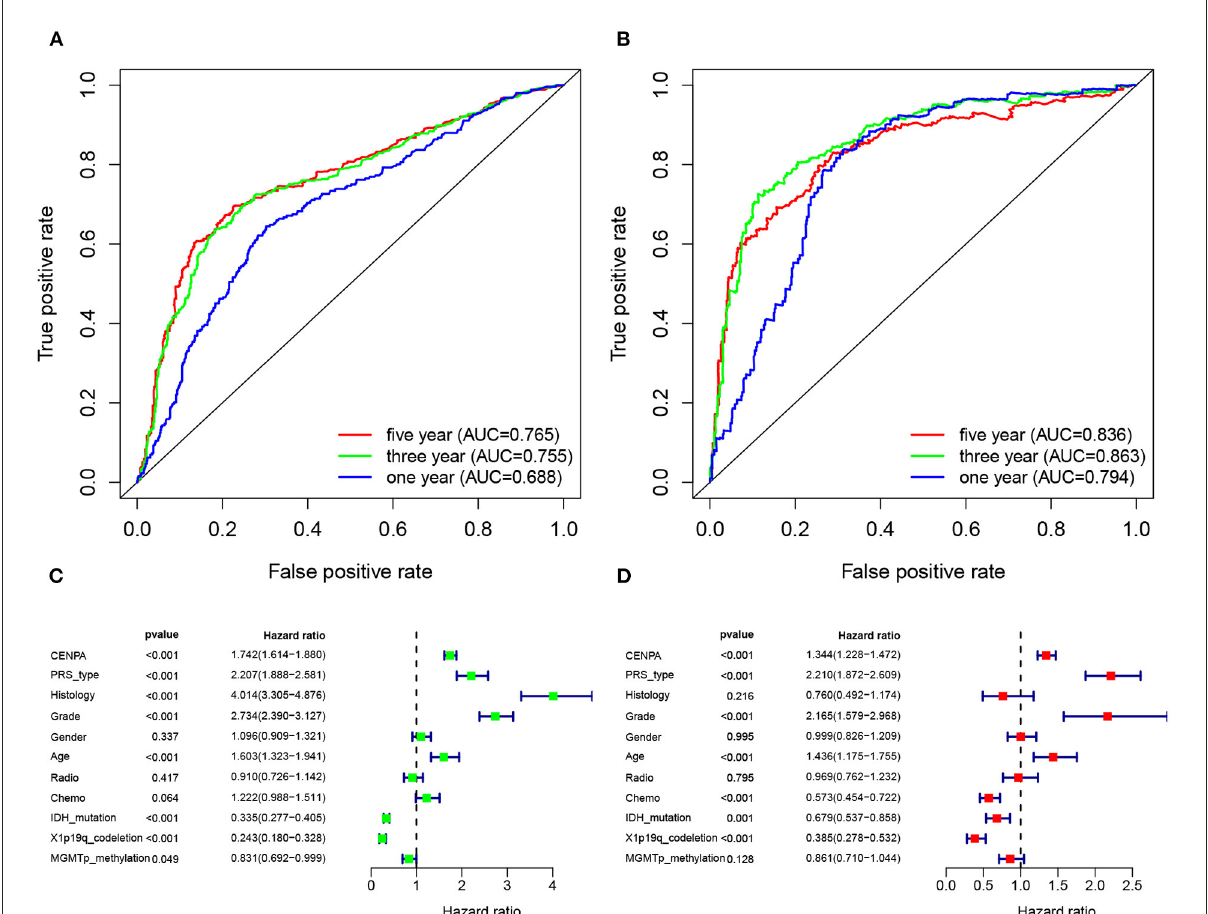
FIGURE10 CENPA expression can be used to determine patient prognosis. The receiver operator characteristic curve analysis of CENPA uses the CGGA database (A) and TCGA database (B) . Univariate analysis (C) and multivariate analysis (D) of CENPA using the CGGA